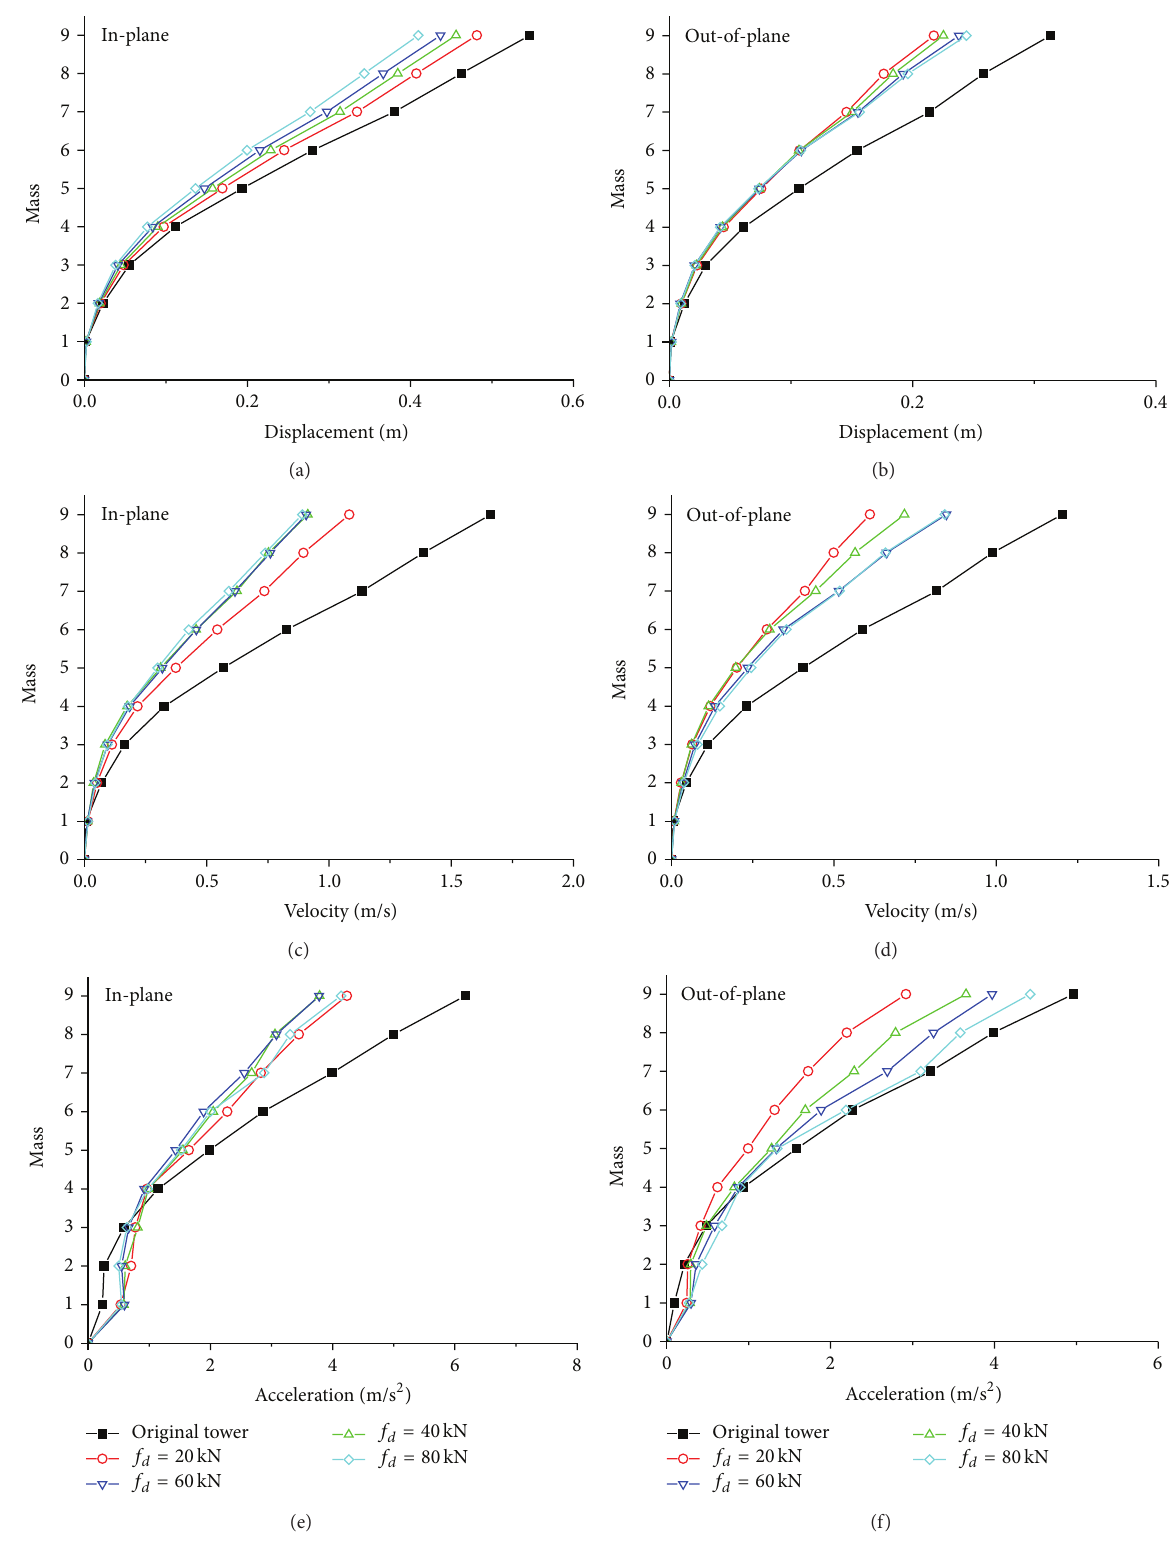
Figure 7: Maximum responses under different damper